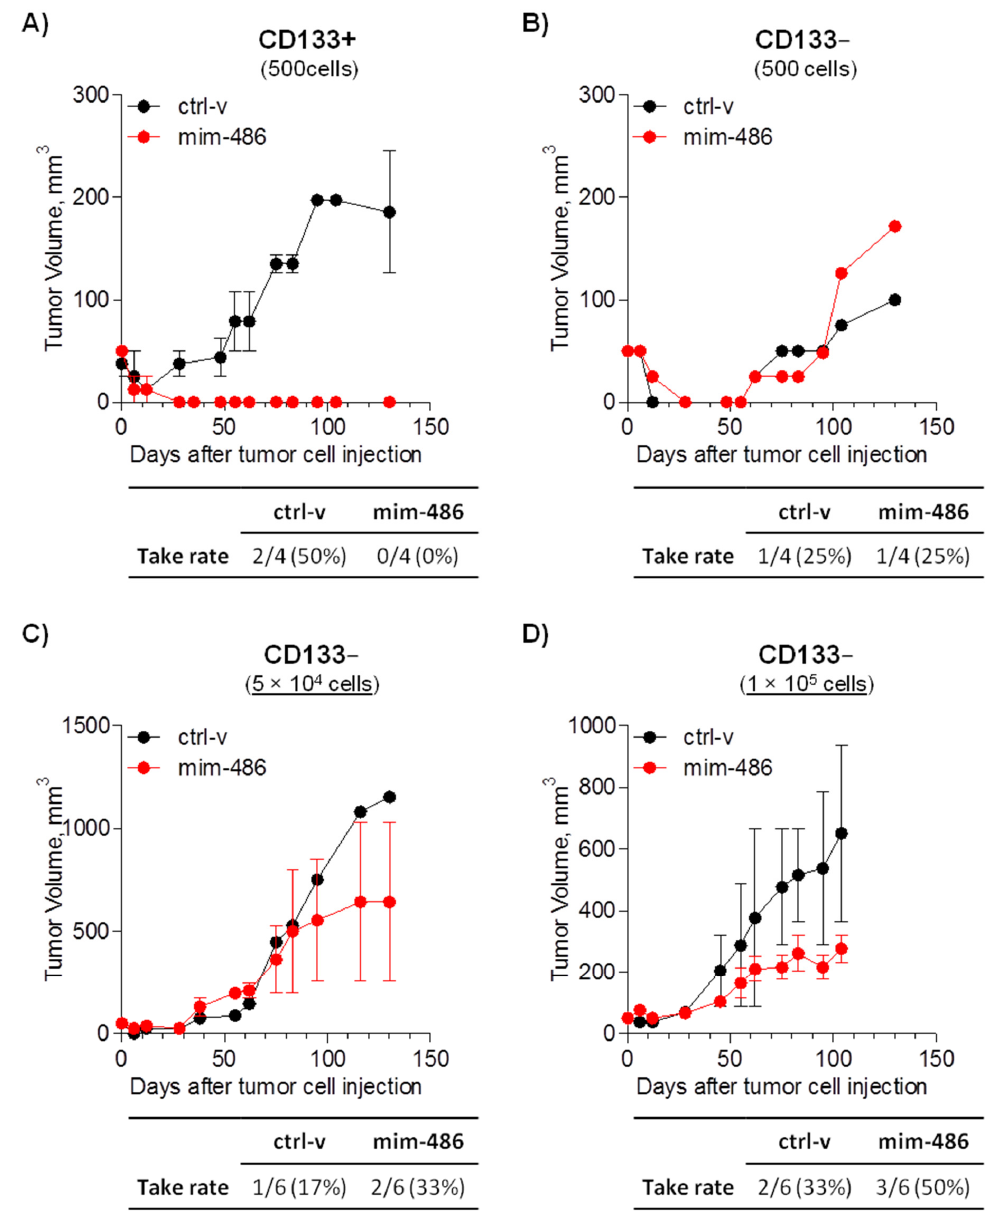
Figure 5. miR-486-5p reduces in vivo tumor take of A549 CD133+ cells. ( A ) Take rate and growth curve of 500 CD133+ cells transfected with the control vector (ctrl-v) or miR-486-5p mimic (mim-486) and injected subcutaneously in SCID mice. Take rate and growth curve of ( B ) 500, ( C ) 5 × 10 4 , and ( D ) 1 × 10 5 CD133 − cells transfected with the control vector (ctrl-v) or miR-486-5p mimic (mim- 486) and injected subcutaneously in SCID mice. Growth curves were obtained considering only established xenograft. All data are expressed as mean ± standard error of the